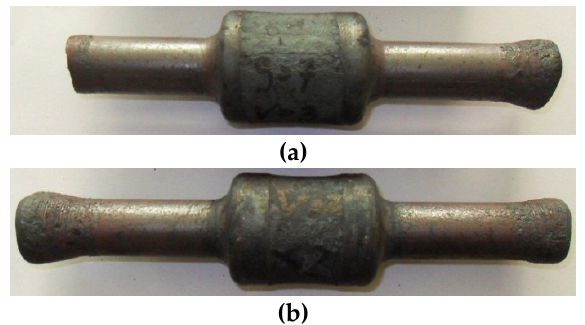
Figure 15. Forgings manufactured in two stages with additional material heating between the operations: ( a ) t o /D = 0.16; ( b ) t o /D = 0.29, ( = 1.9, v/n = 8 mm/rotation)